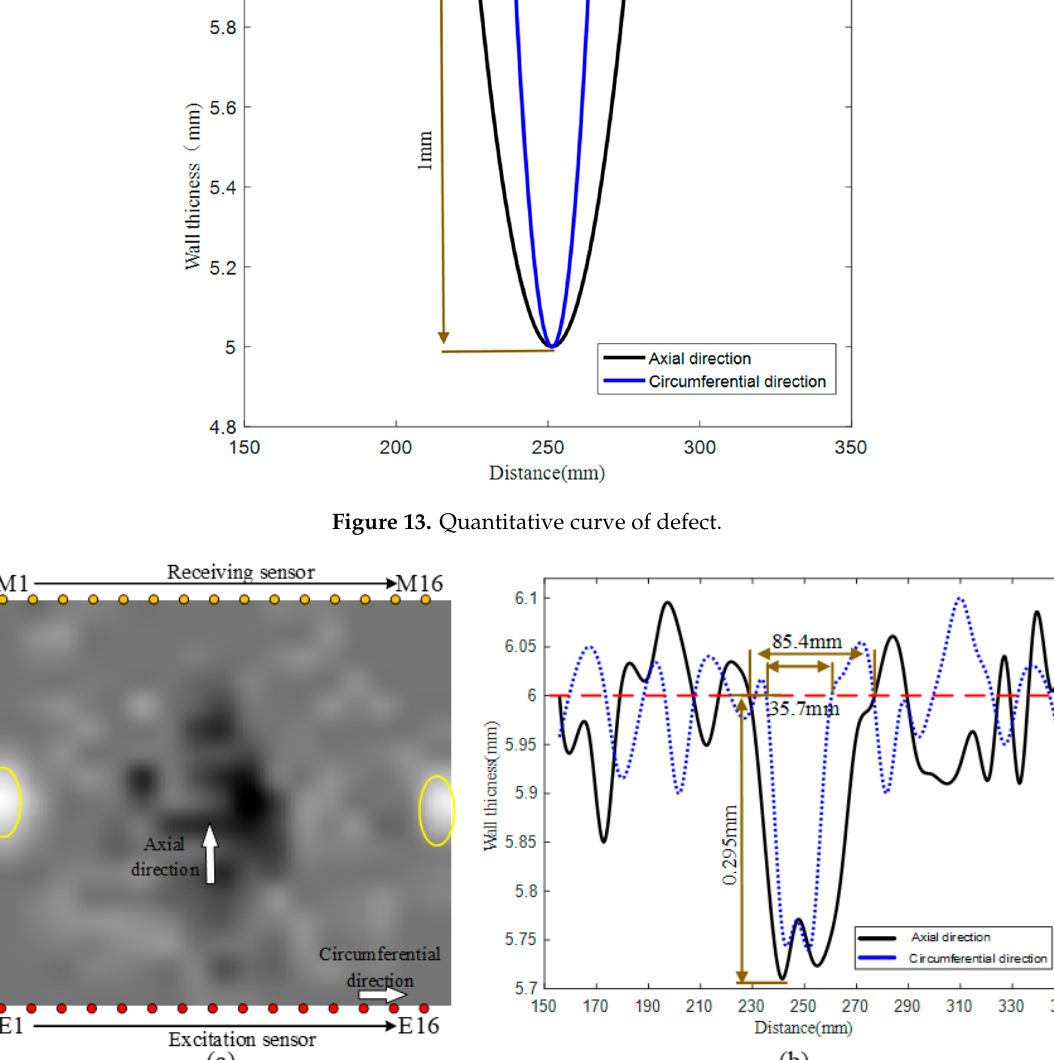
Figure 14. Image reconstruction results of elbow with defect in extrados: ( a ) Reconstruction results of wall thickness map; and ( b ) identification results of the defect size. Table 2. Location identification result of the defect.